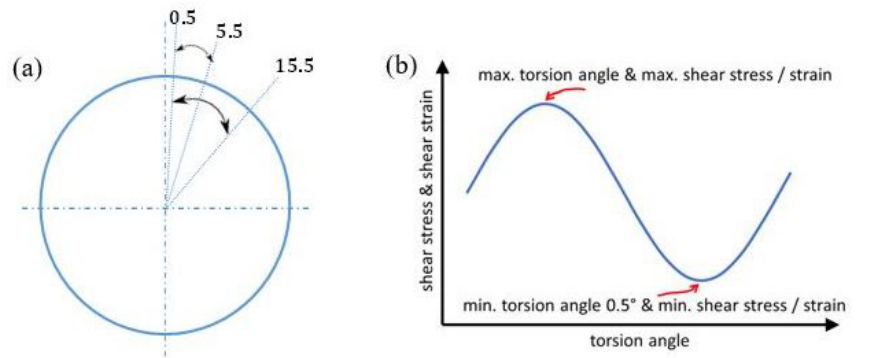
Figure 2. ( a ) Schematic depiction of sample cross section in the middle of gauge length, describing the range of angles used. ( b ) Cycle of applied torsional angle, red arrows mark values for stress and strain presented